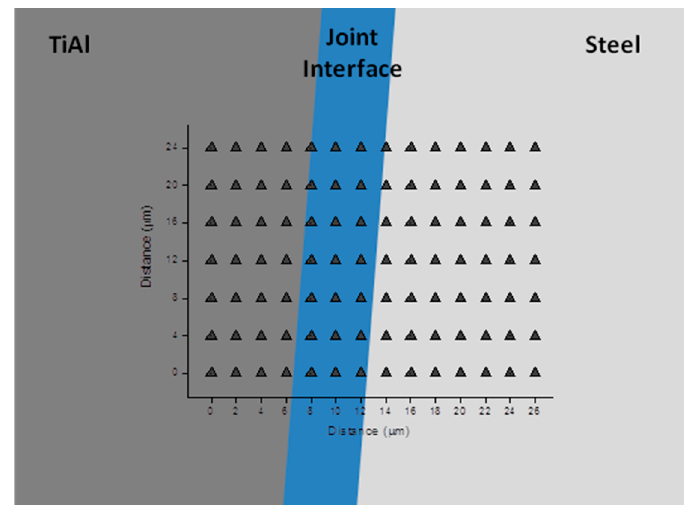
Figure 1. Scheme of the nanoindentation tests position ( ) across the joints.